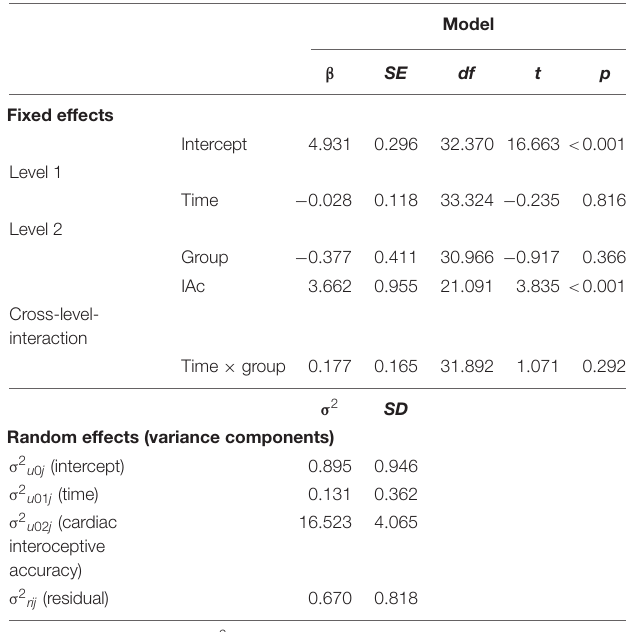
TABLE 3 | Model 5: Random intercept and random slope model for interoceptive sensibility with the predictors time, group, cardiac interoceptive accuracy, and the interaction of time and